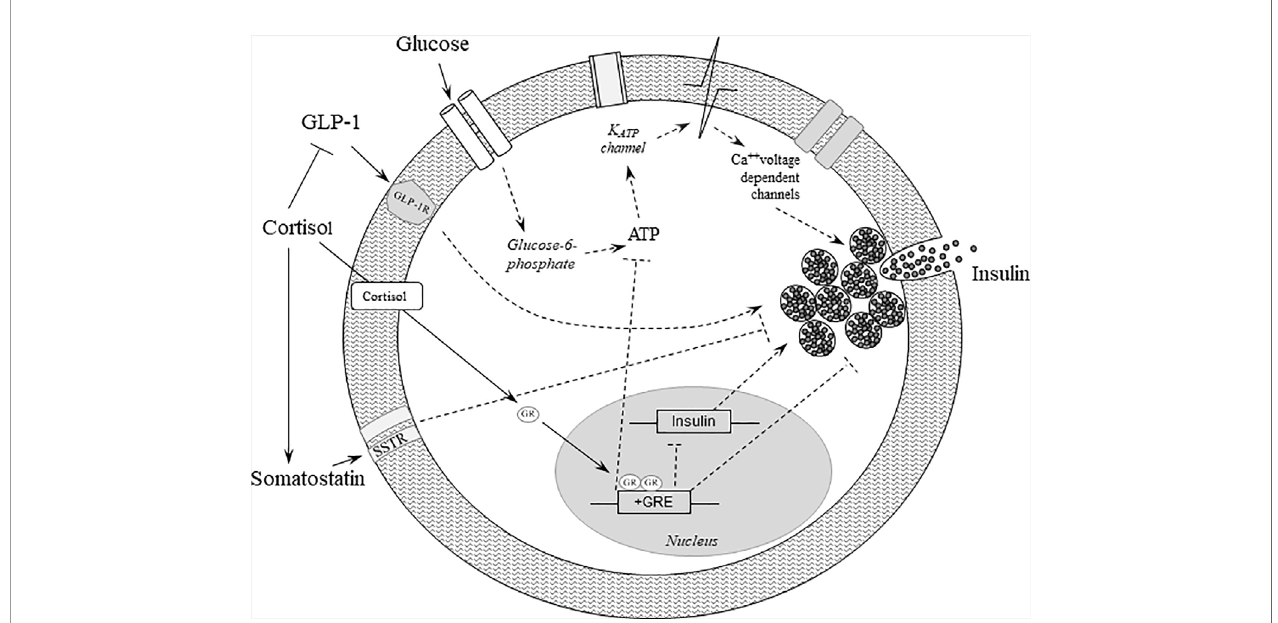
FIGURE 1 | Effects of glucocorticoids on beta-cell function. Binding of glucose to the GLUT2 receptor increases oxidative metabolism and ATP synthesis, thereby leading to the closure of the K ATP channels, which in turn stimulates membrane depolarization and insulin secretion. Cortisol binds to and activates the glucocorticoid receptor, which translocates to the nucleus and initiates several cascades culminating in repression of insulin transcription and inhibition of insulin release. In addition, cortisol further deteriorates beta-cell function by reducing GLP-1 production and its positive effects on insulin secretion, and by increasing the secretion of somatostatin, which in turn negatively impacts insulin gene transcription and insulin secretion. Dashed lines represent indirect effects. ATP, adenosine triphosphate; Ca, Calcium; GLP-1, glucagon-like peptide 1; GLP-1R, glucagon-like peptide 1 receptor; GLUT2, glucose transporter 2; GR, glucocorticoid receptor; GRE, glucocorticoid response element.